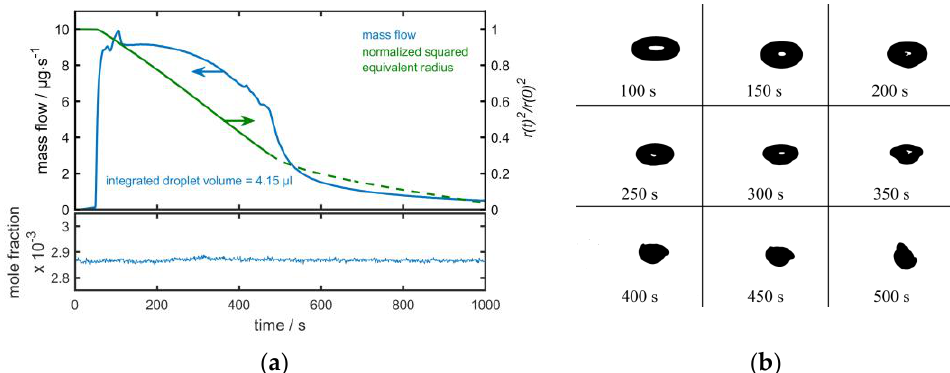
Figure 5. ( a ) Top: Measured H 2 O mass flow of a levitated 10 wt% lysozyme solution droplet at a drying temperature of 60 °C and a nitrogen flow rate of 1.0 nl/min (blue); normalized squared equivalent radius 𝑟(𝑡) 2 /𝑟(0) 2 calculated from the initial droplet volume (green) the green dashed line (starting from 450 s) does not show the real physical behavior of the droplet radius after the critical point of drying, but is only given for completeness. Bottom: Measured H 2 O mole fraction of the reference path for the monitoring of the free space Perspex chamber. ( b ) Shadowgraphy images of the levitated protein solution droplet over the drying process.